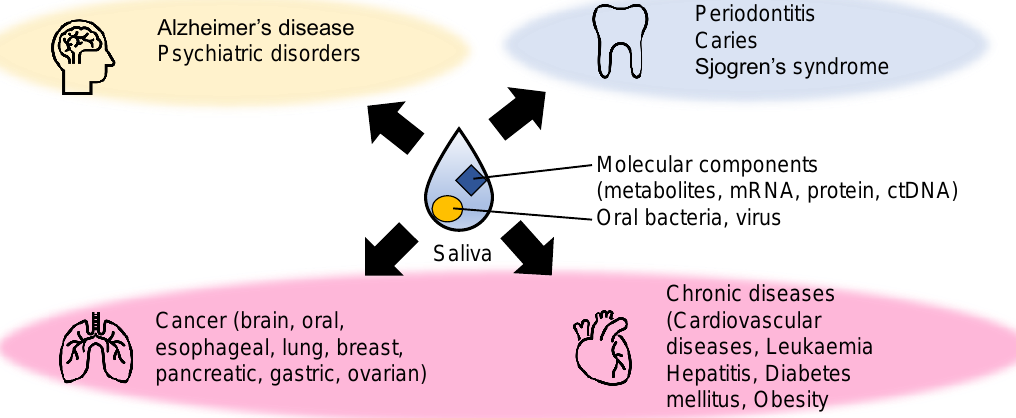
Figure 1. Examples of diseases detected using metabolite biomarkers. The biomarkers of mental illnesses (yellow), dental diseases (light blue), and various systematic diseases (light pink) related to metabolic abnormalities have been explored.